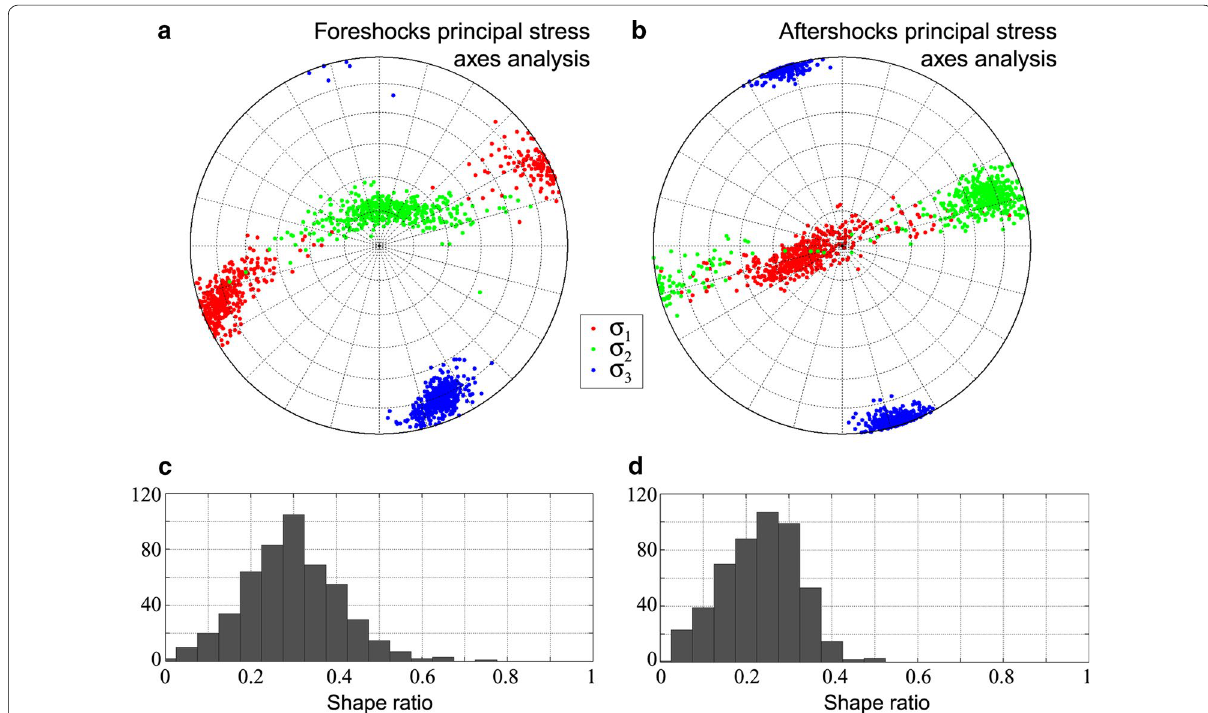
Fig. 11 Principal stress axes analysis for foreshocks (left) and aftershocks (right) by method of Michael (1984) with uncertainty estimate coded by Vavryčuk (2014); panels a , b show confidence limits of principal stress axes visualized by 500 randomly perturbed pure shear solutions by the approach of Vavryčuk (2014) for foreshocks and aftershocks, respectively. In panels c , d are histograms of their respective shape ratios defined as = σ 1 − σ 2 . Note that the relatively low shape ratios imply σ 1 ≈ σ σ 1 − σ 3